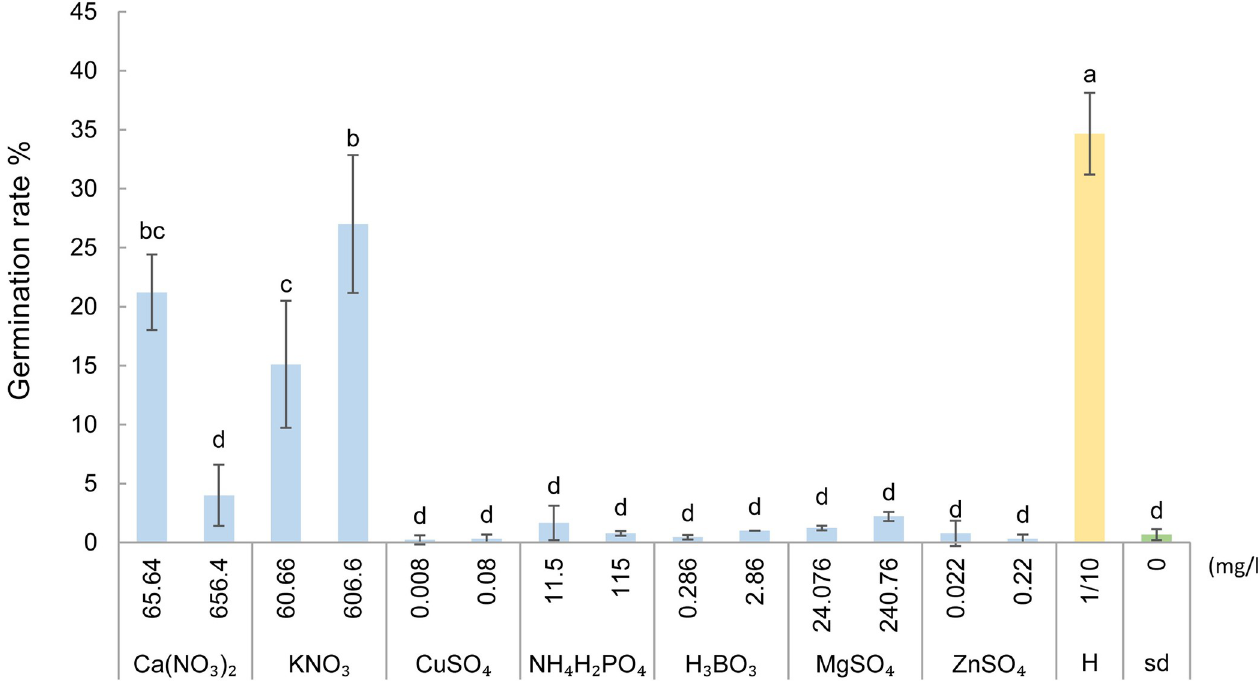
Fig 3. Germination rates of non-sterile resting spores of P . brassicae incubated with Iso4 bacterial suspension in various solutions after 7 days. The positive control of 1/10 strength Hoagland solution (H) is indicated in yellow. The negative control of sdH 2 O (sd) is indicated in green. Error bars represent standard deviation s. Different letters represent significant differences among the treatments (Wilcoxon rank sum test. P < 0.05, n = 3).